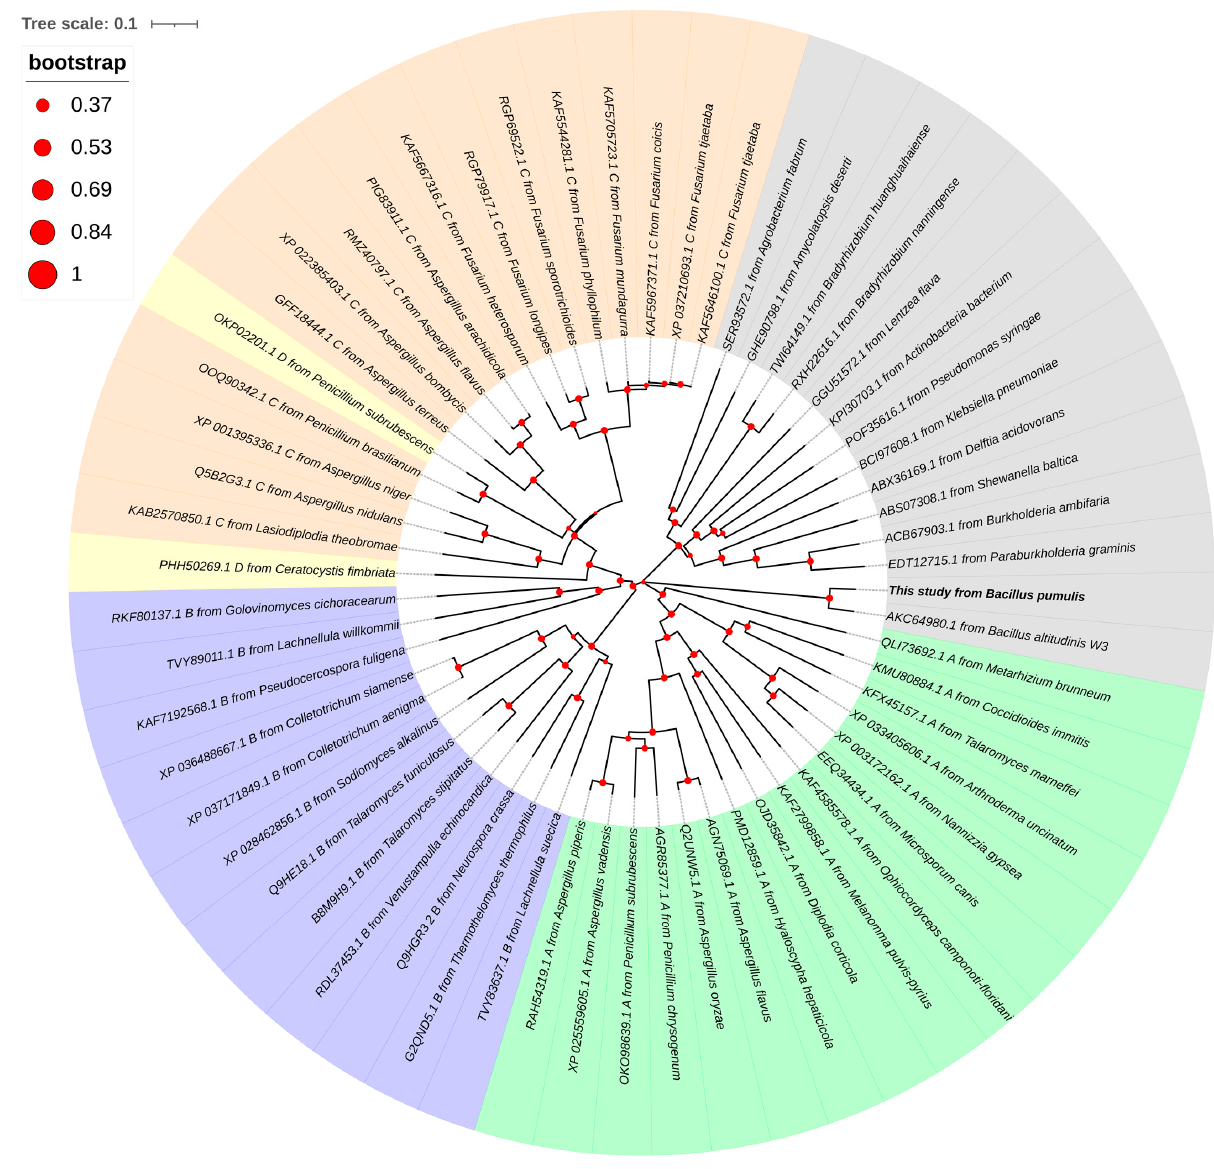
Figure 1. Sequence analysis of BpFAE. ( a ) The amino acid sequence of BpFAE from B. pumilus was aligned with BaFAE from B. altitudinis (GenBank ID: AKC64980), R18 from Streptomyces cinnamoneus (PDB: 5YAE), SpFAE from S. pogona (GenBank ID: WP_190824464), and PeFAE from P. eucalypti (GenBank ID: WP_185062649). The strictly conserved amino acids are displayed with a red background. The sequences with high similarity are shown against a yellow background. Two typical domains (GXSXG and HGGG) are indicated by a blue frame. ( b ) Phylogenetic tree based on a neighbor ‐ joining algorithm using MEGA 7. Four types (A, B, C, D) and other FAEs from bacteria are highlighted in green, purple, orange, yellow, and grey, respectively.